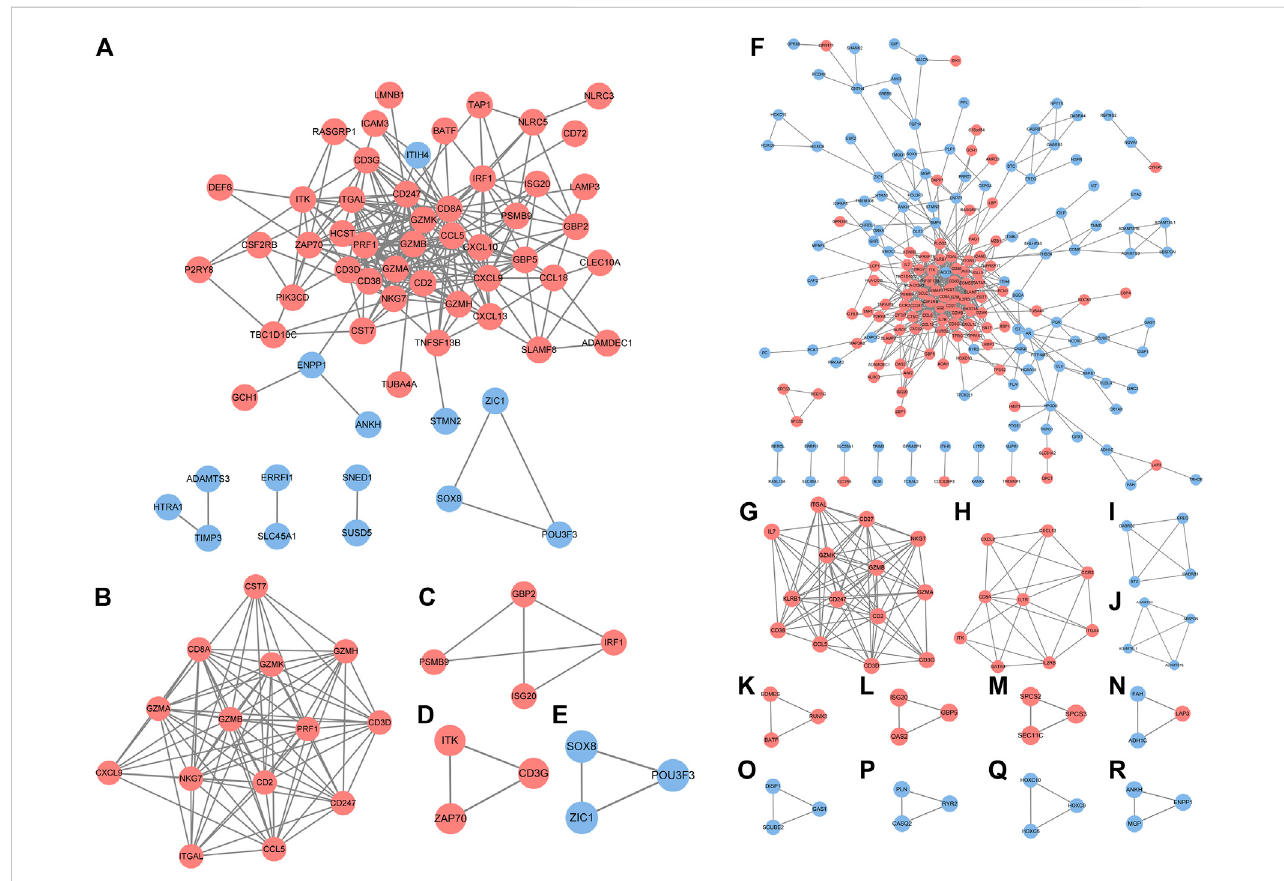
FIGURE 3 PPI network analysis of DEGs between RA-LJ/RA-SJ samples and OA samples. (A) Cytoscape network visualization of RA-LJ and OA samples that were obtainedwithinteractionscores > 0.4accordingtotheSTRINGonlinedatabase (B – E) Fourkeymoduleswereidenti fi edbyClusterOne. (F) Cytoscapenetwork visualization of RA-SJ and OA samples (G) – (R) 12 key modules were identi fi ed by ClusterOne. The nodes represent genes, and the edges represent links between genes. Red represents upregulated genes, and blue represents downregulated